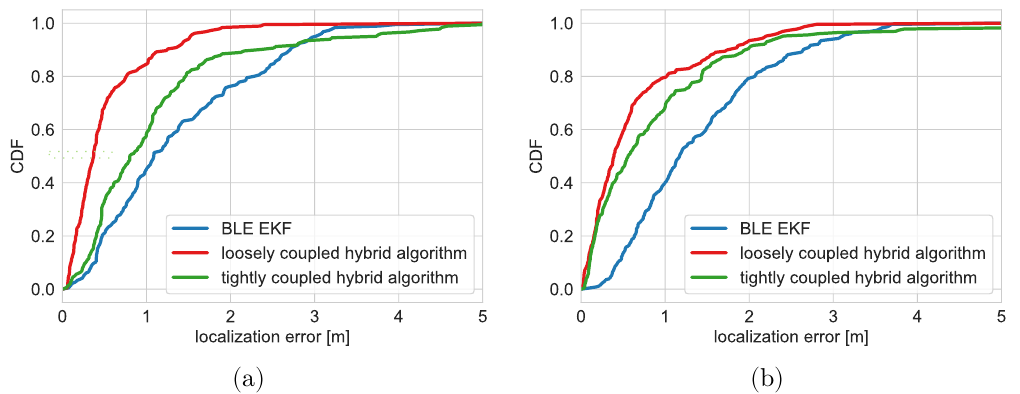
Figure 6. Empirical Cumulative Distribution Functions of localization error for: ( a ) scenario 1, ( b ) scenario